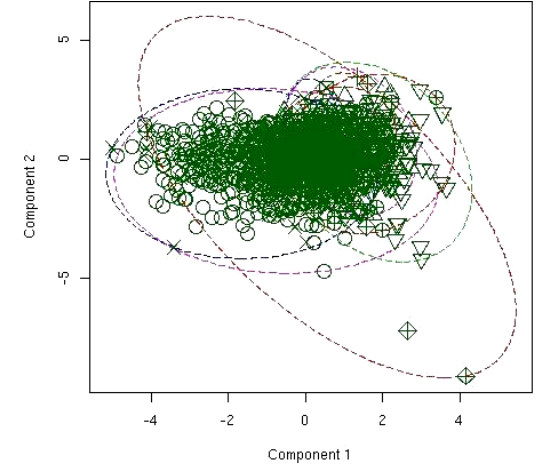
Fig. 1. Size of Clusters by KFCM.